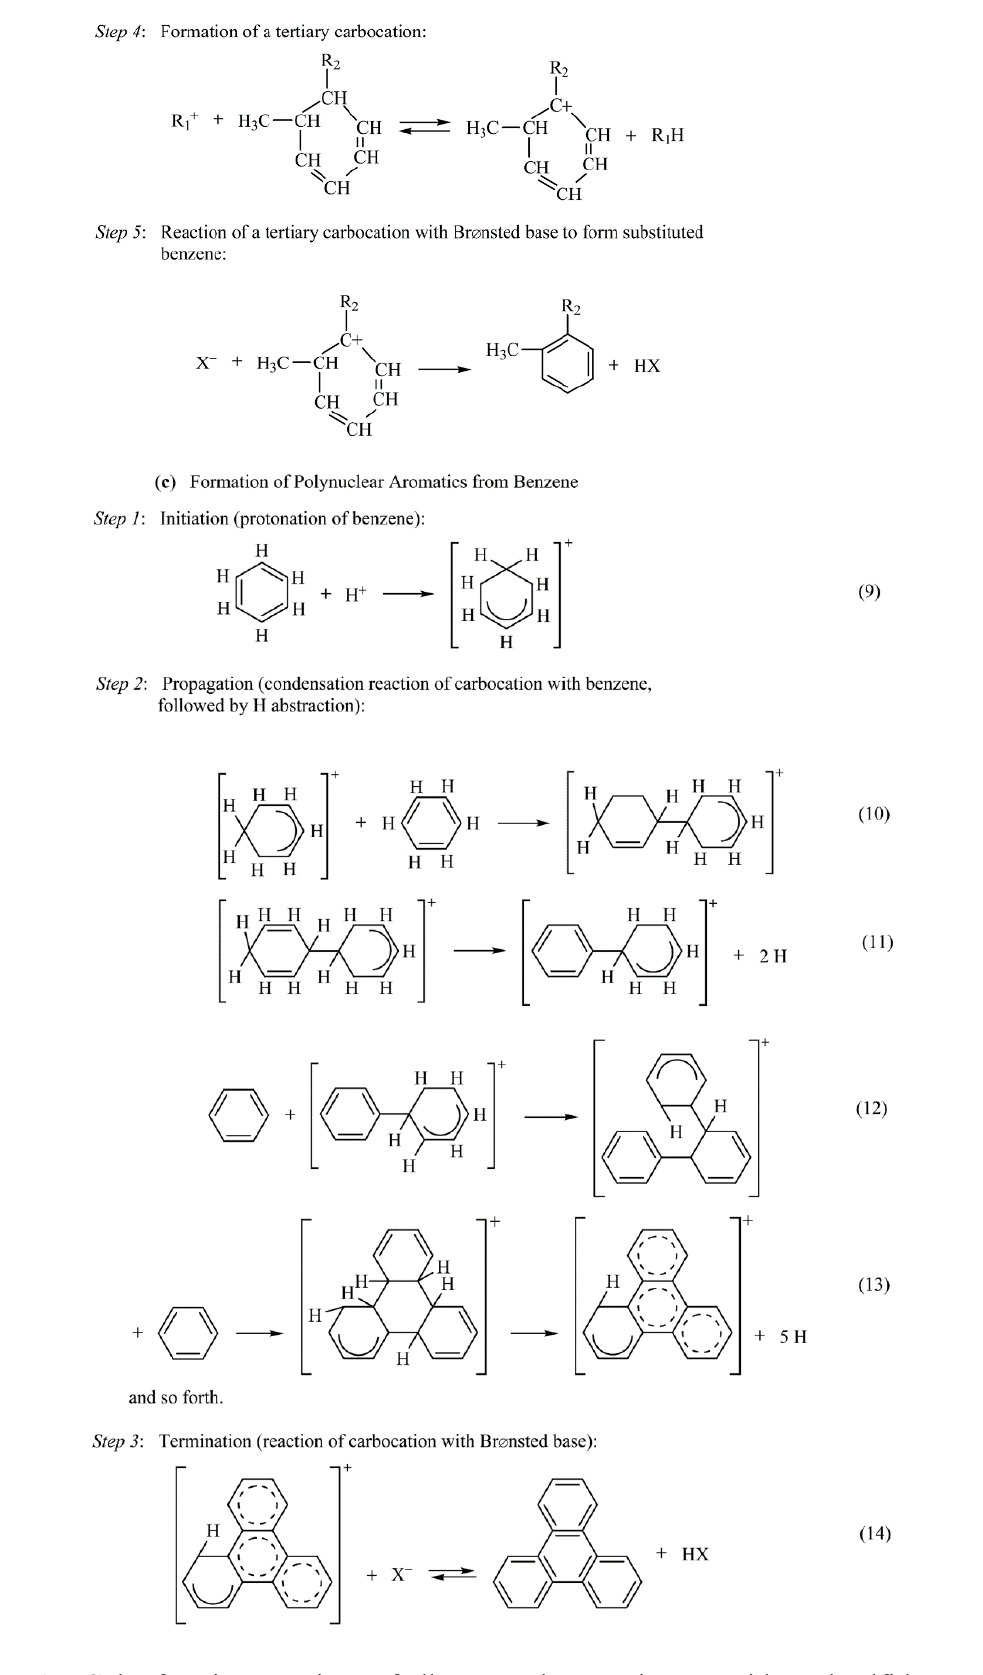
Figure 15. Coke-forming reactions of alkenes and aromatics on oxide and sulfide catalysts: ( a ) polymerization of alkenes, ( b ) cyclization from alkenes, and ( c ) formation of polynuclear aromatics from benzene. Reproduced from [8], Copyright 2006,